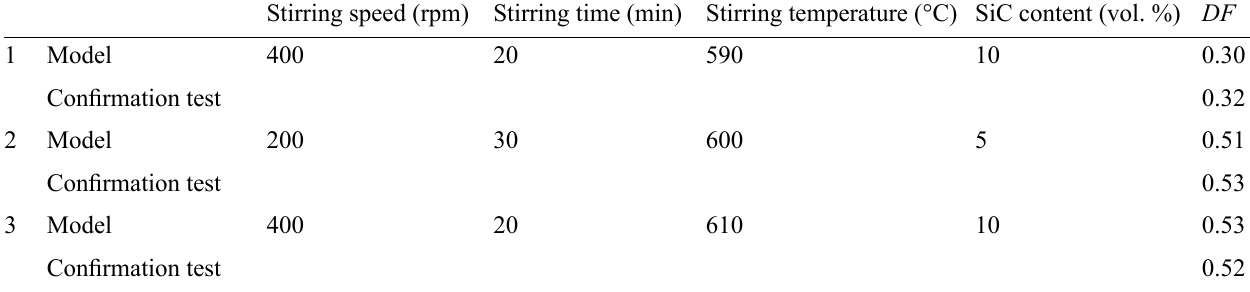
Table 5. Results of confirmation tests.